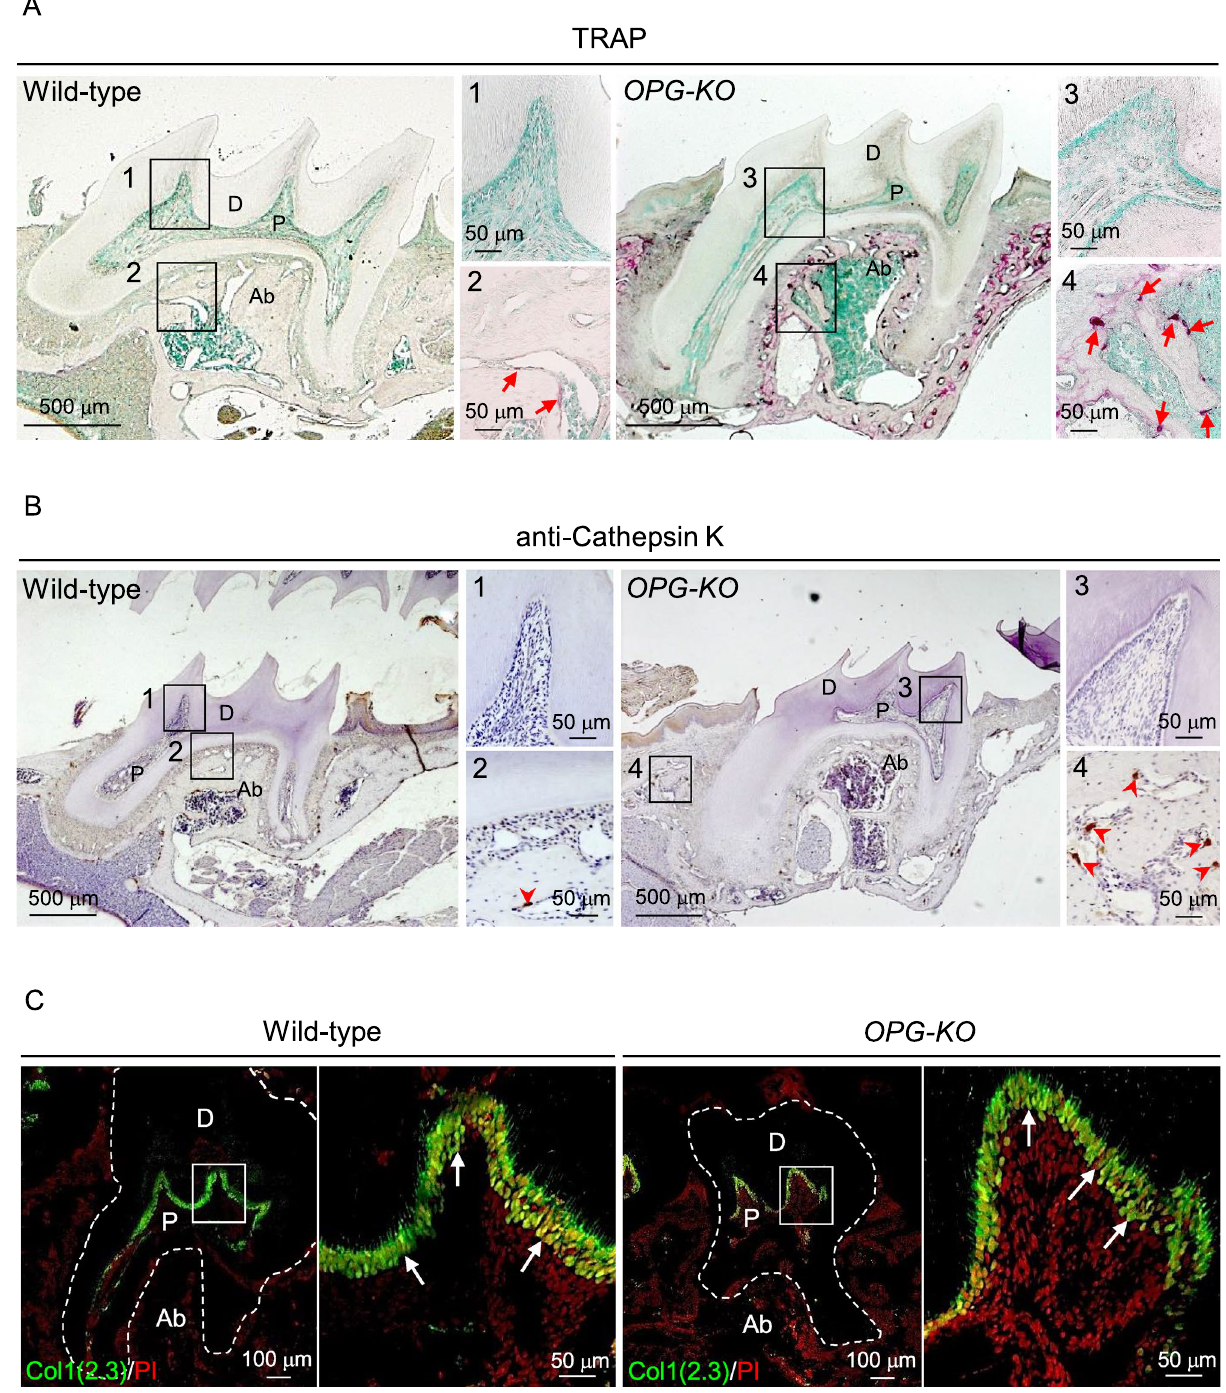
Figure 2. OPG is not required to maintain the pulp environment in normal tooth. ( A , B ) Representative images of 6-week-old mouse maxillary first molars from wild-type and OPG-KO mice stained with TRAP ( A ) and anti-cathepsin K antibody ( B ). The tissues were counter stained with methyl green ( A ) or hematoxylin ( B ). Red arrows: TRAP + osteoclasts, red arrowheads: cathepsin K + osteoclasts. Numbered panels are magnified views of boxed areas. n = 3. ( C ) Representative confocal images of maxillary first molars from 6-week-old Col1(2.3)-GFP ; wild-type and Col1(2.3)-GFP ; OPG-KO mice. Nuclei were visualized using PI. White arrows: Col1(2.3)-GFP + odontoblasts. Right panels are magnified views of boxed areas. n = 3. P: pulp, D: dentin, Ab: alveolar